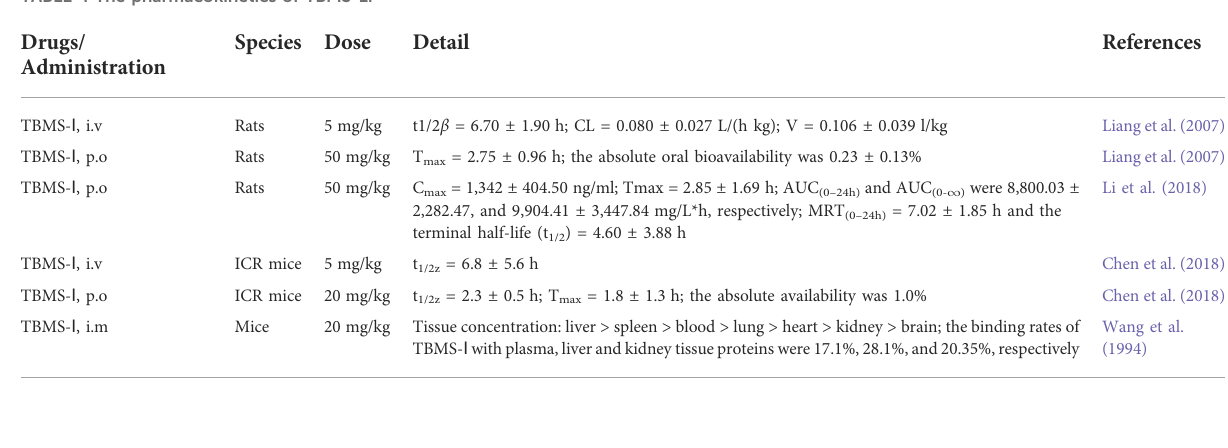
TABLE 4 The pharmacokinetics of TBMS-1.